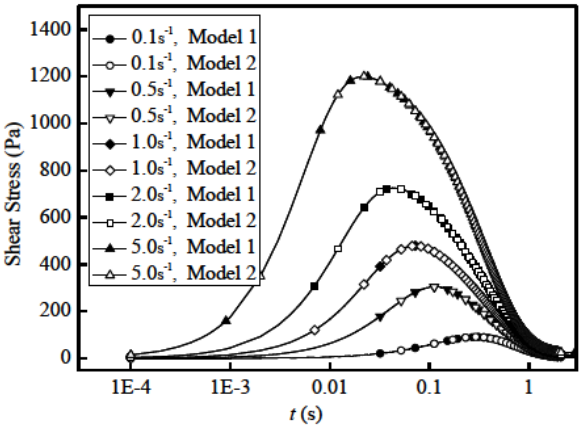
Figure 6: The partial graph of rheological data described by Model 1 and Model 2